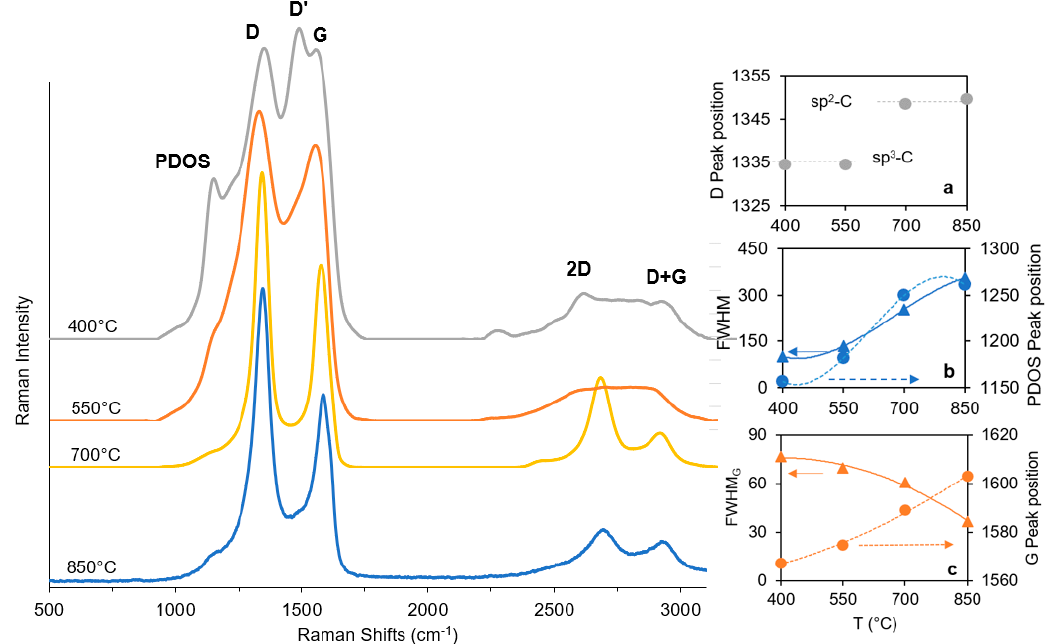
Figure 5. Raman spectra of sample growth at 400 °C, 550 °C, 700 °C, and 850 °C at a 2000 ppm [B]/[C] ratio. In the inserts ( a – c ), peak position and full-width at half-maximum (FWHM) are reported.